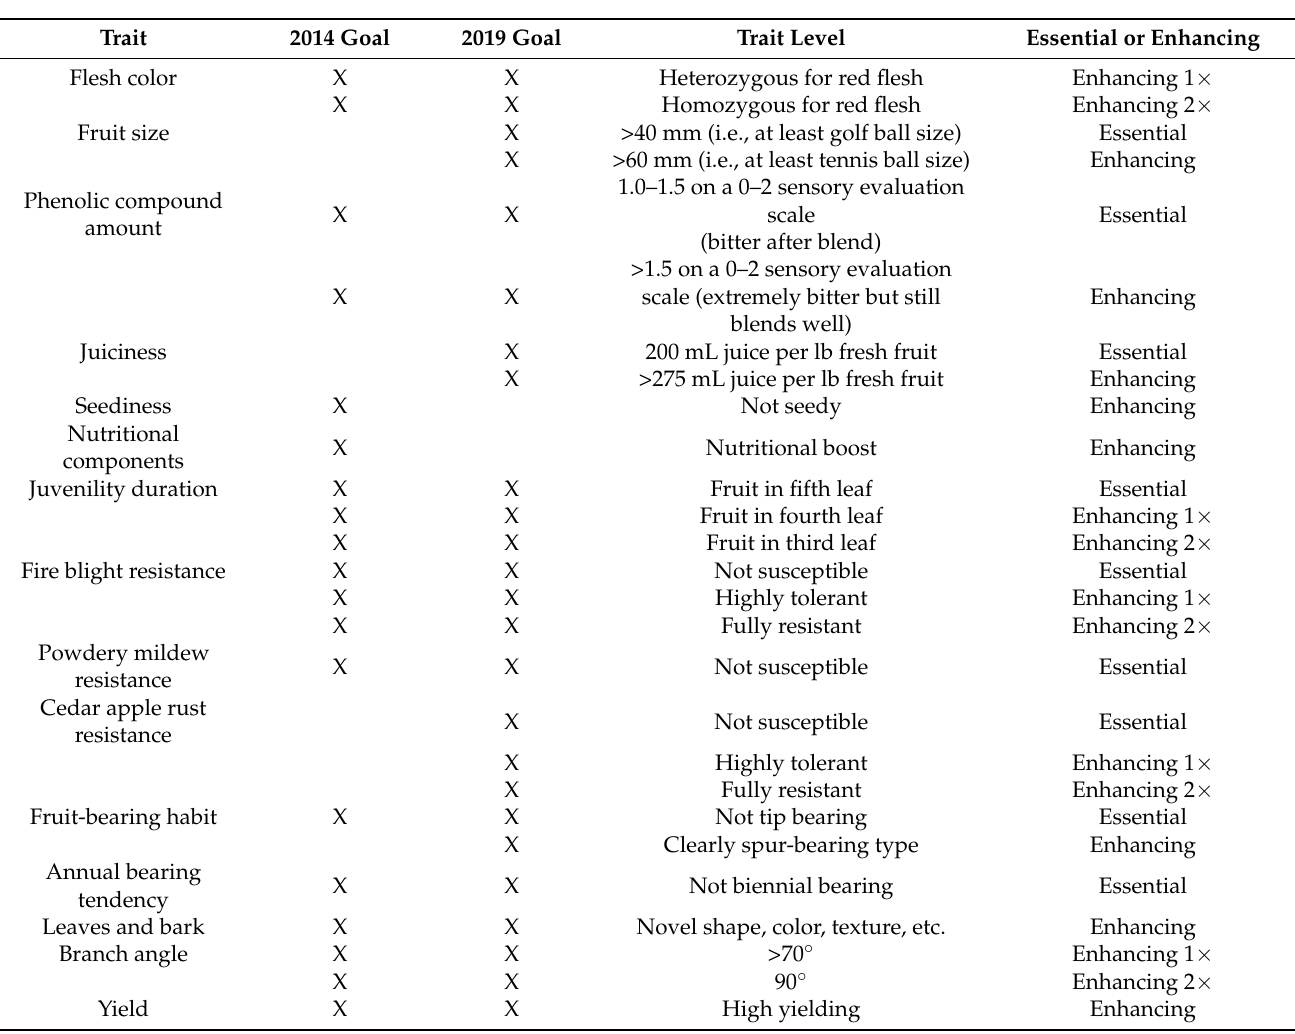
Table 1. List of target traits in the student run PWCabp, including trait levels and their designation as essential or enhancing. Essential attributes are those that represent the minimum level of a trait for a cultivar produced in the program, while enhancing attributes are those that are above and beyond targeted trait levels and can boost cultivar value. Some traits possessed a second, more enhancing level (2 × ) beyond the basic enhancing level of these traits (1 ×